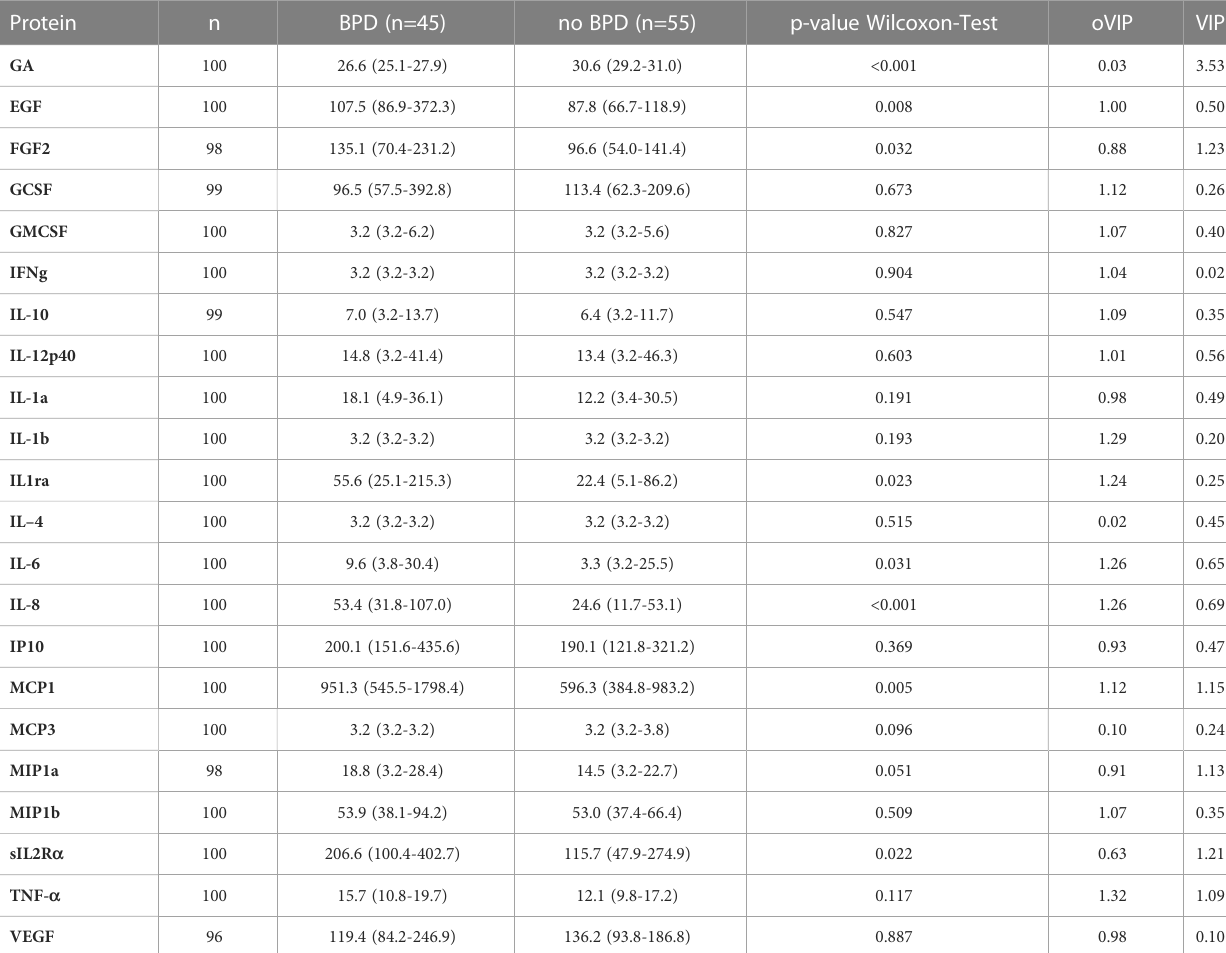
TABLE 3 Comparison of protein abundance at birth.